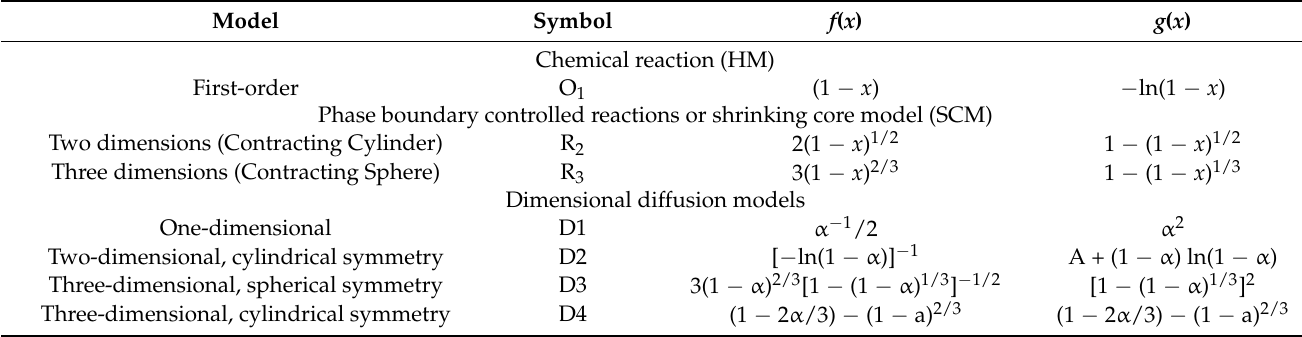
Table 2. Expressions of f ( x ) and g ( x ) for the kinetic model functions